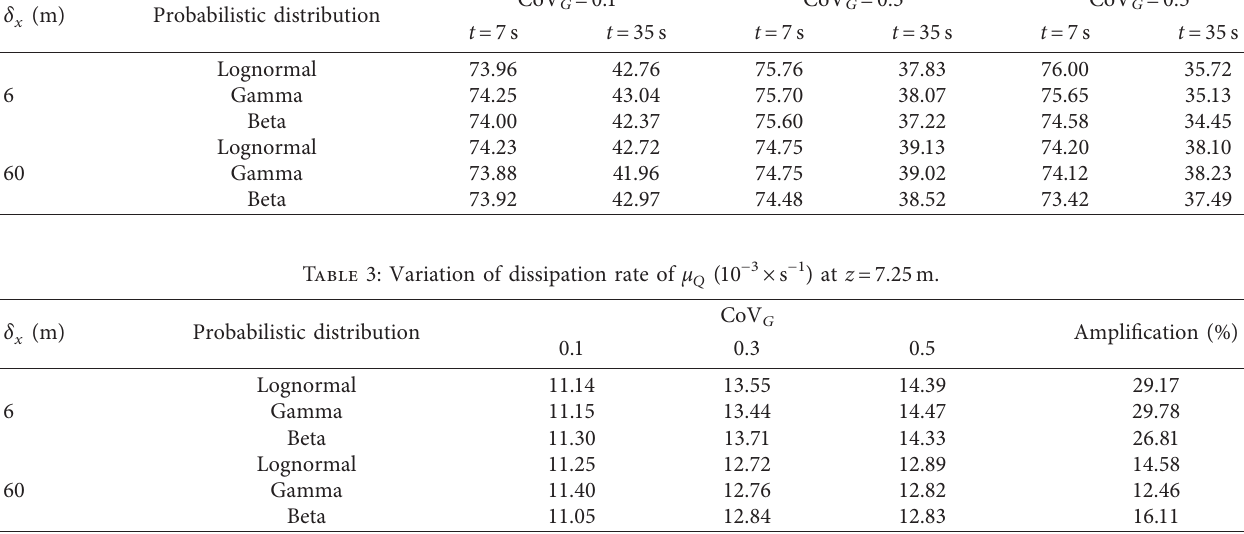
δ x (m) Probabilistic distribution